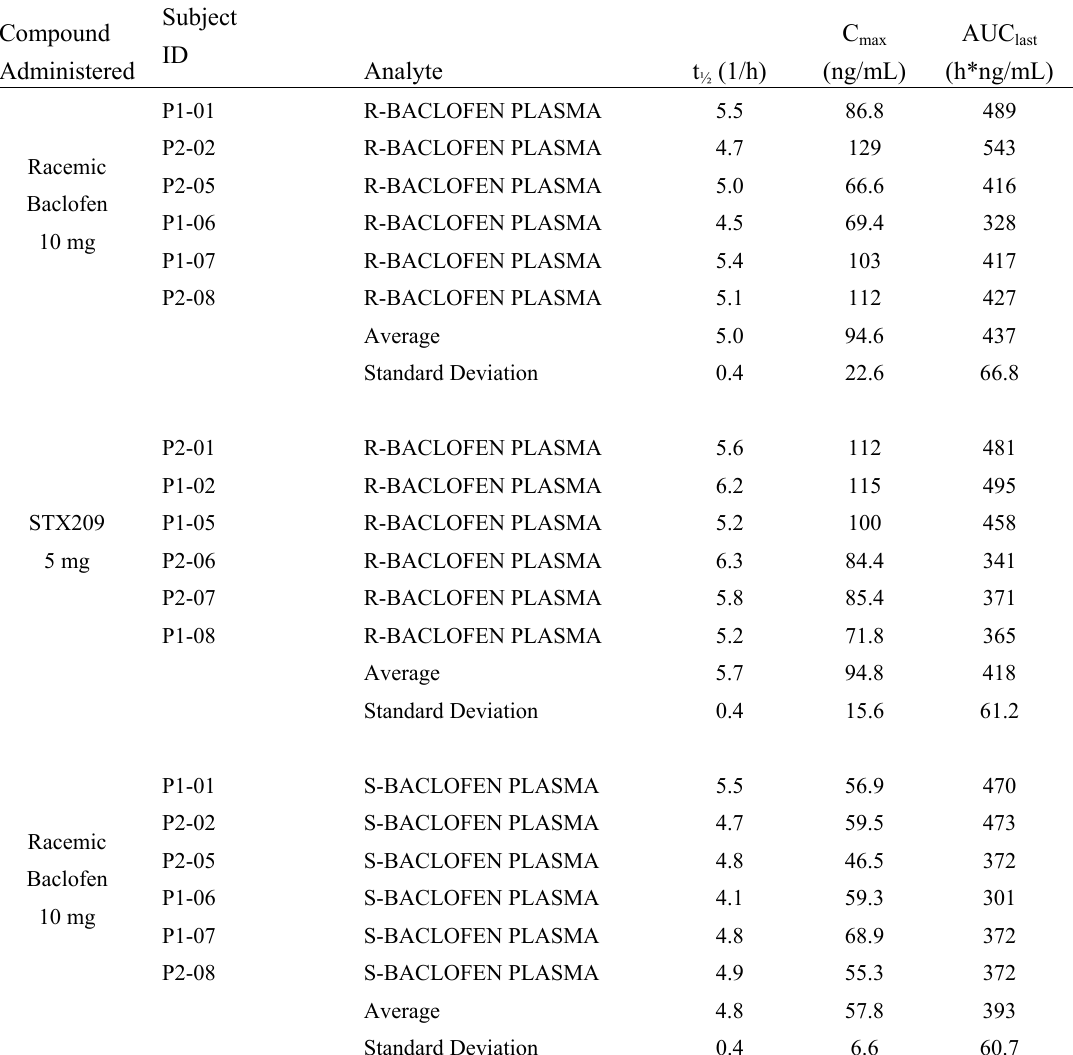
Table 2. Pharmacokinetic parameters of human subjects dosed with baclofen or STX209. Data provided to one decimal place or 3 significant figures. Dose administered: 5 mg